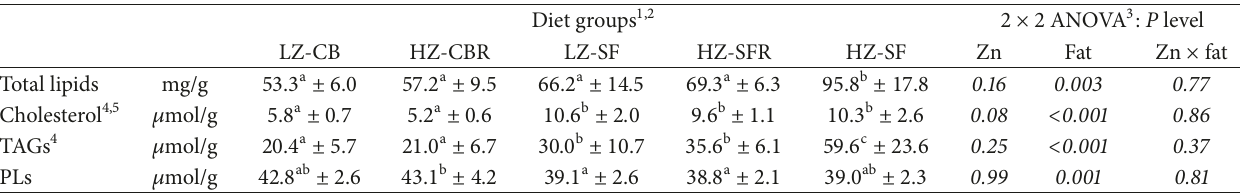
Table 3: Lipid concentrations in the liver (wet weight) of male weanling rats fed high-fat diets differing in Zn content and fat source free choice or in restricted amounts for 4wk.